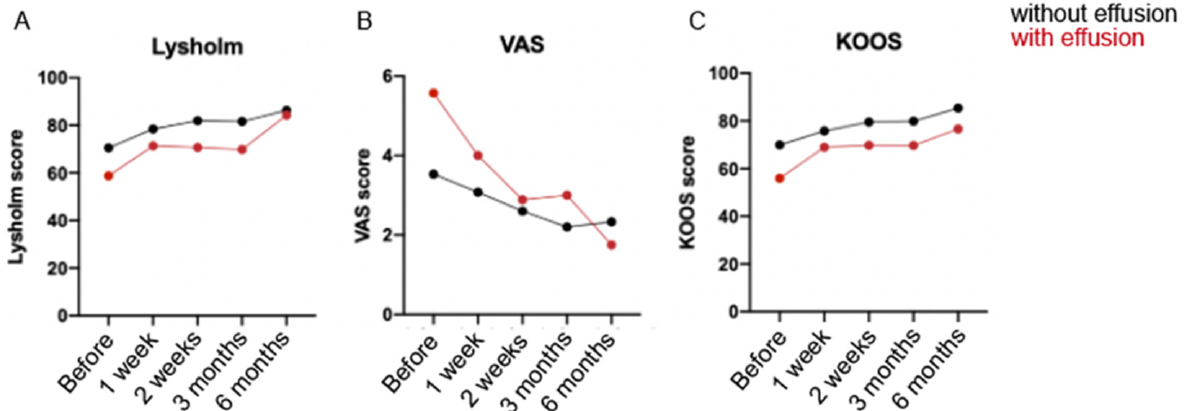
Figure 3. Graphs showing the Lysholm-Tegner ( A ), VAS ( B ) and KOOS ( C ) scores. Clinical data after 6-month follow-up after hyperacute serum treatment in OA knee at different time points: before the treatment, and after it at week 1, week 2, 3 months and 6 months. Red represents the clinical data from patients with effusion in the knees and black, without effu- sion.